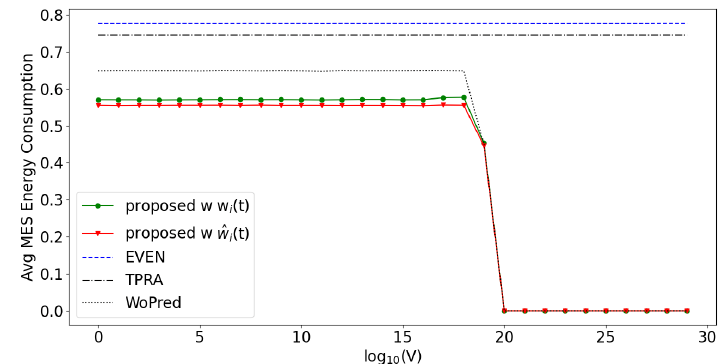
Figure 6. Average energy consumption of a MES with different V when N = 3.